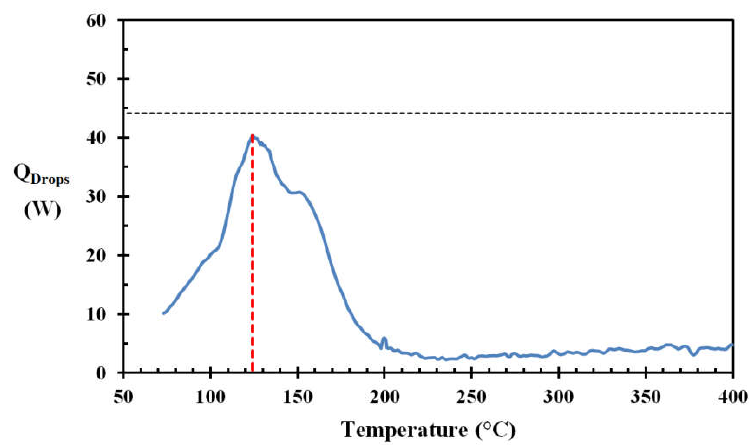
of temperature. The temperature at the maximum cooling rate is marked ( red ).